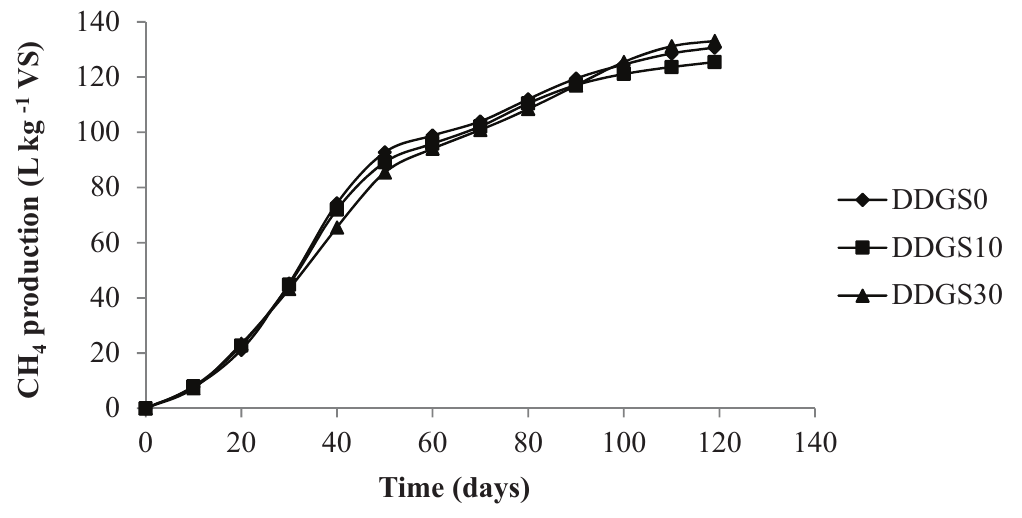
Figure 1. Effects of feeding strategy (adding 0%, 10%, 30% of corn dried distillers’ grains with solubles (DDGS)) on manure CH 4 emissions (L CH 4 ·kg (cid:2)1 volatile solids (VS)) over a 4-month storage experiment.